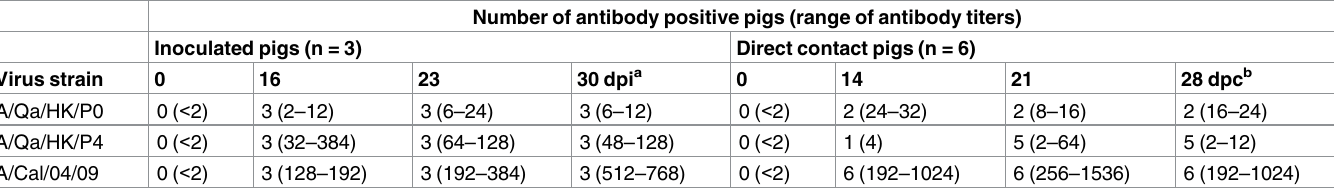
Table 2. Antibody responses in inoculated and direct contact pigs involved in transmission experiments measuredby VN test.